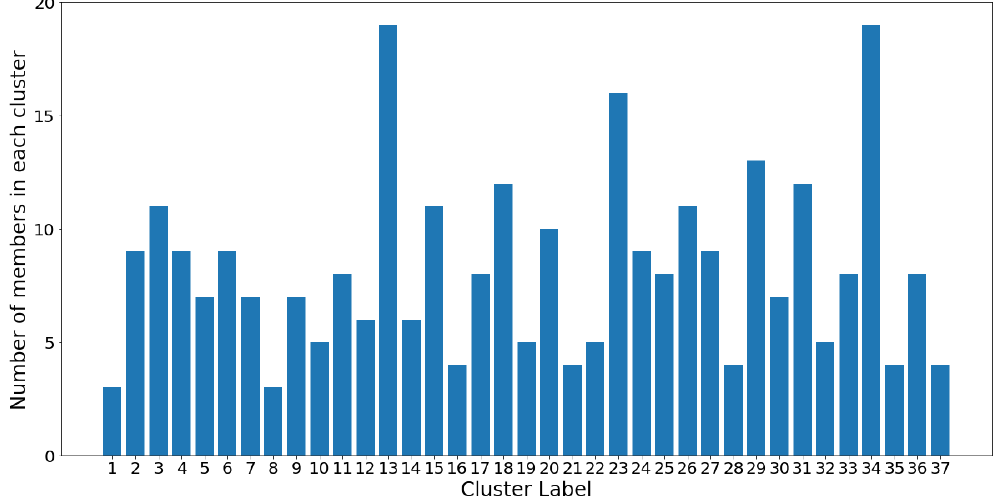
Figure 12. Cluster populations for UPGMA dendrogram with K = 37